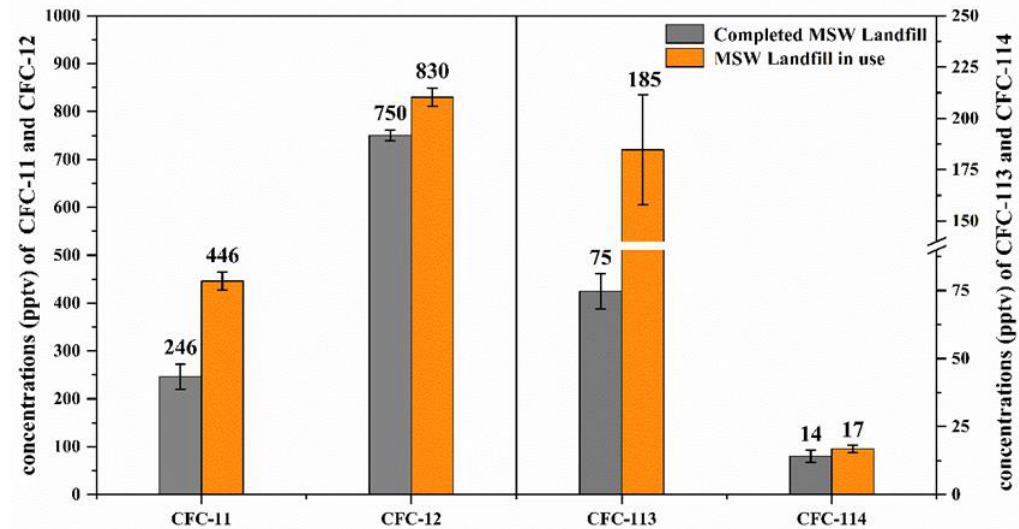
Figure 4. Mean concentrations of CFCs at municipal solid waste (MSW) landfills in Jiyang (JY) (completed) and Liaocheng (LC) (in use).